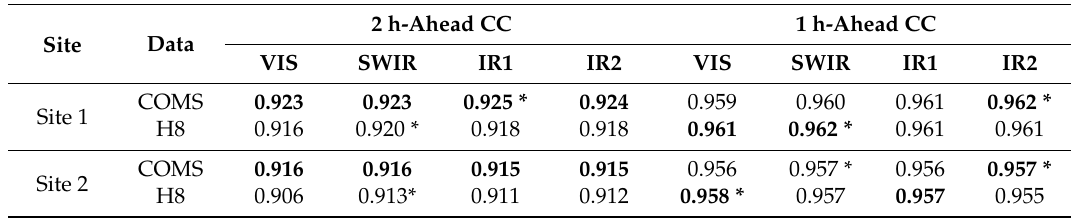
Table 10. CC results from PV forecast using the DNN model (bold text indicates the higher CC value between COMS and H8 while the asterisk emphasizes the highest CC values for each dataset per